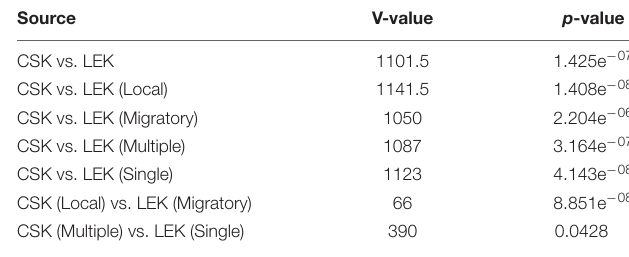
TABLE 2 | A table showing results from a Wilcoxon signed-rank test with continuity correction comparing mean habitat scores between local ecological knowledge (LEK) and conventional science knowledge